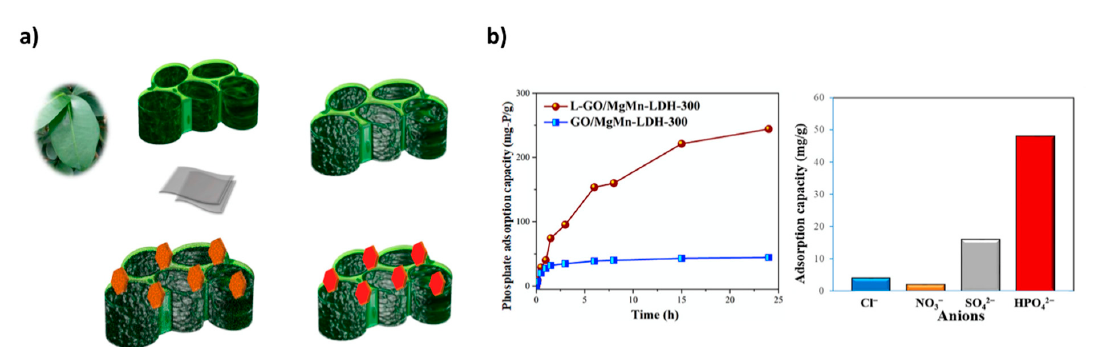
Figure 14. Garcinia subelliptica leaves templates for GO / MgMn-LDH based removal of phosphate anions. ( a ) Scheme of the templated assembly. ( b ) Phosphate anion adsorption capacity of L-GO / MgMn-LDH-300 compared to that of the calcined LDH composite without leaf-template (GO / MgMn-LDH-300) (left) and anion selectivity of L-GO / MgMn-LDH-300 (right). Figure reprinted from Ref. [178] with permission from Elsevier.